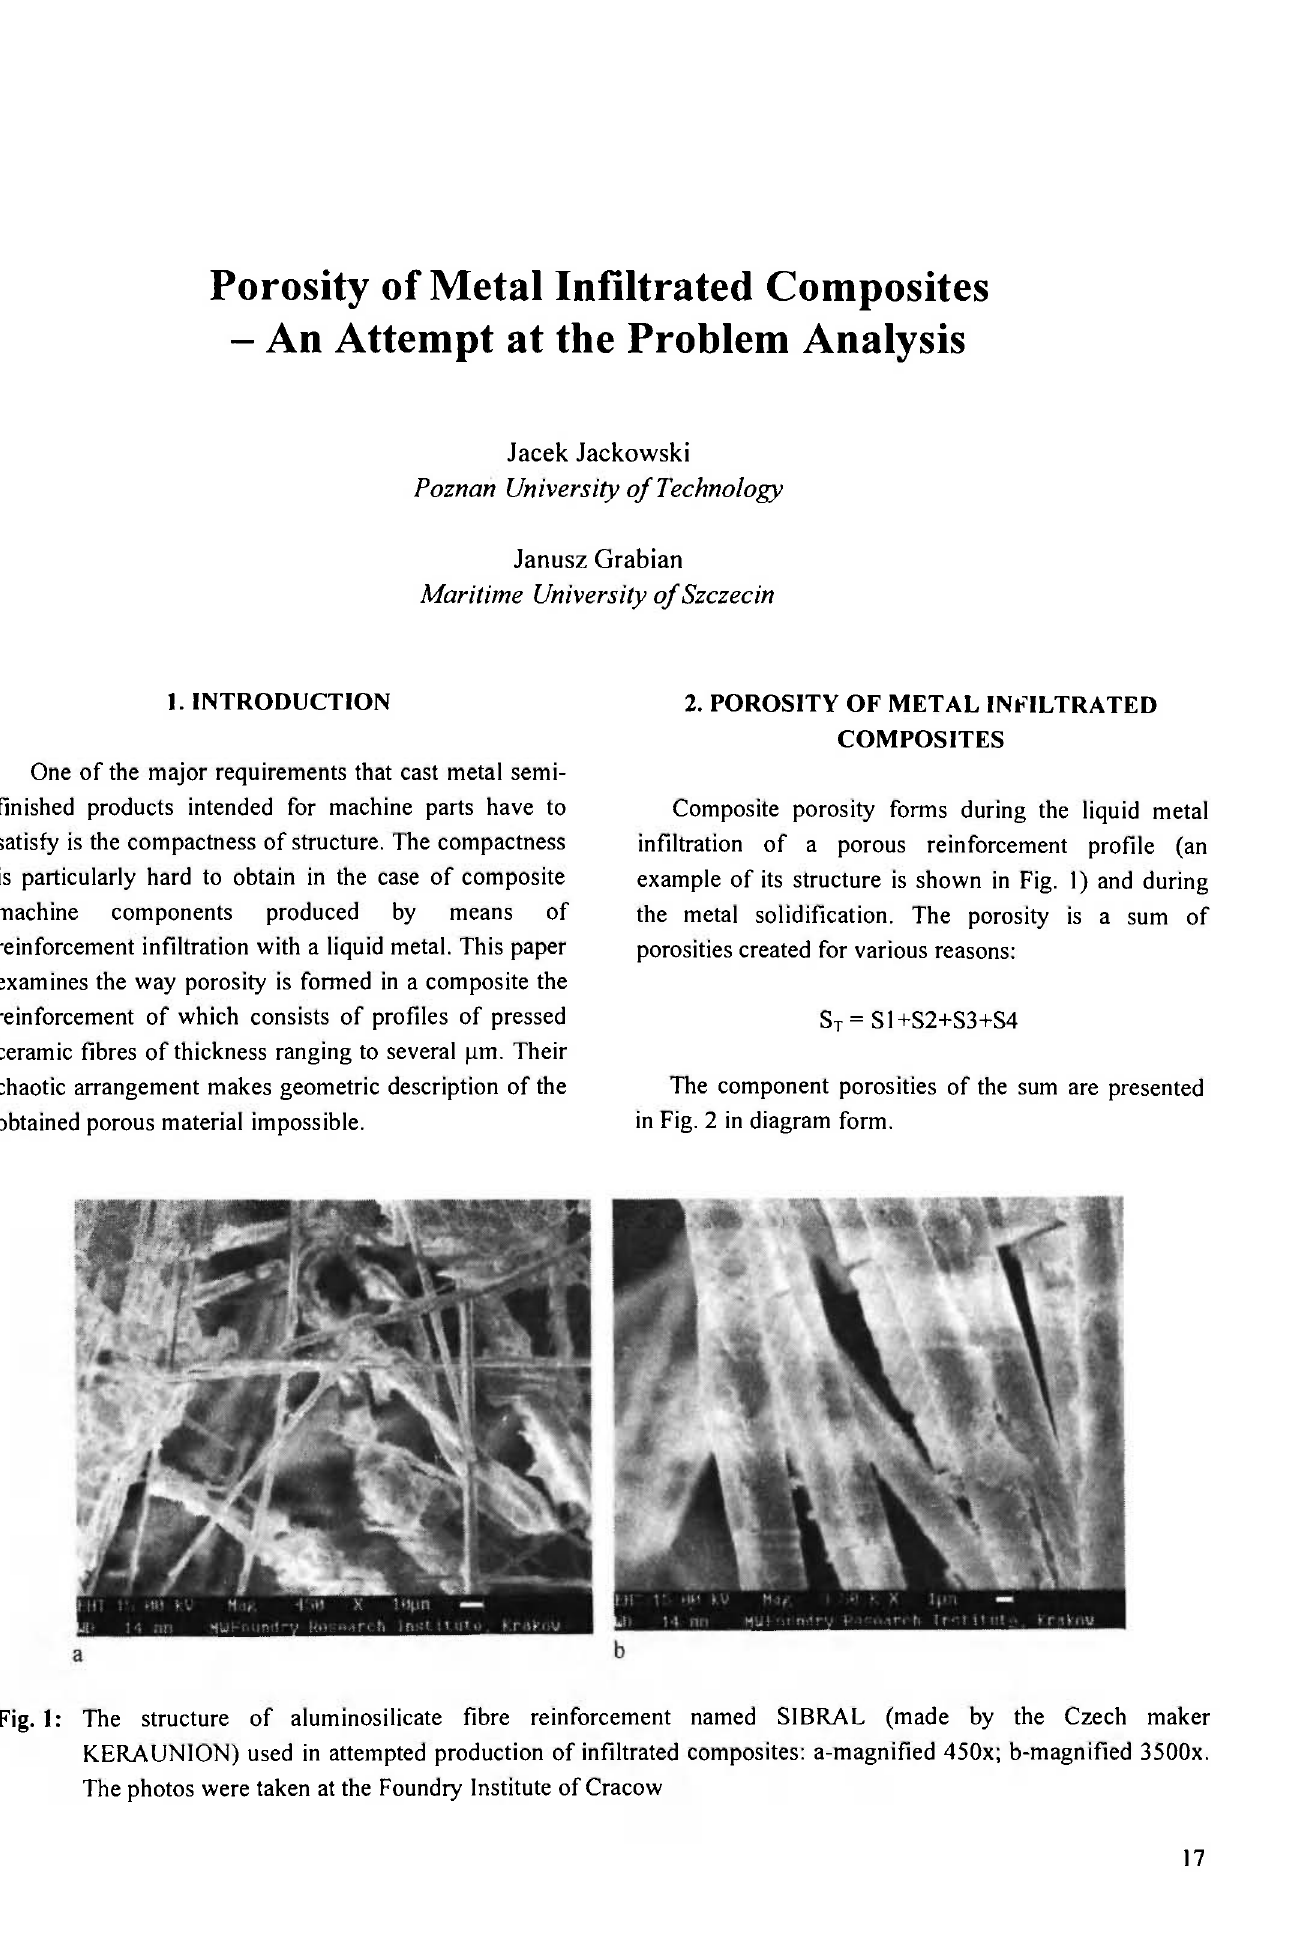
Fig. 1: The structure of aluminosilicate fibre reinforcement named SIBRAL (made by the Czech